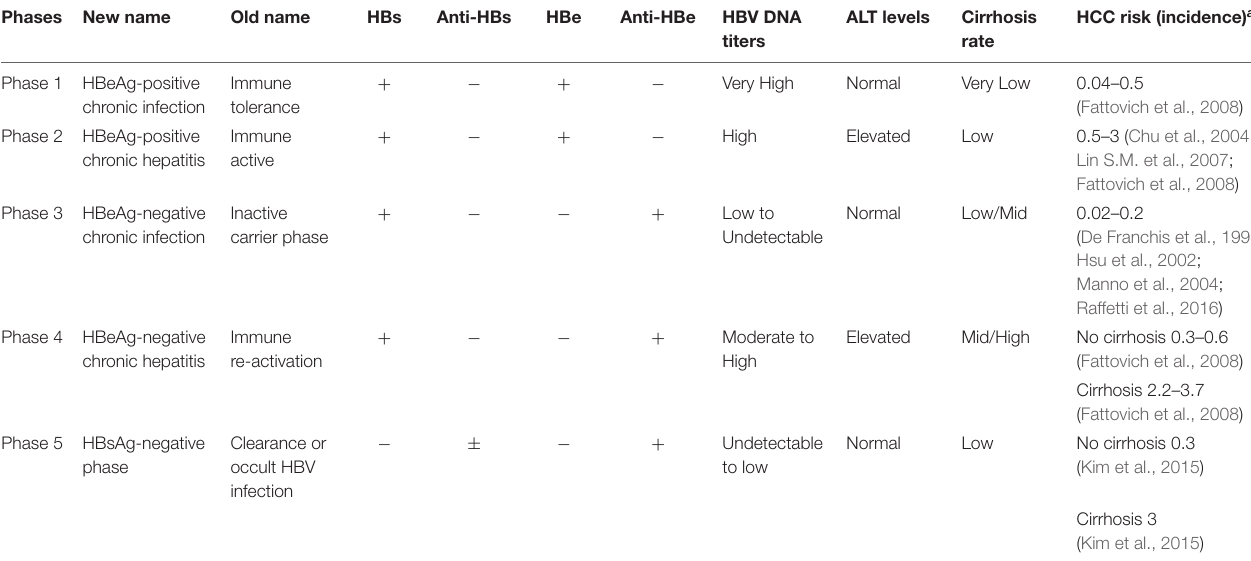
TABLE 1 | Natural history of patients with chronic HBV